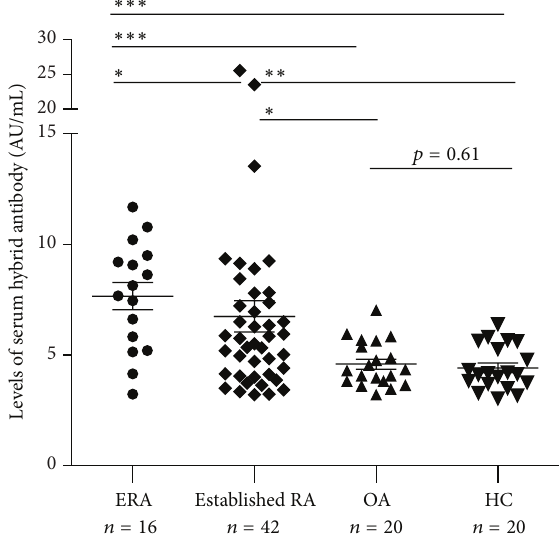
Figure 1: Comparison of levels of 𝜅 / 𝜆 hybrid antibody in the sera of patients with treatment na¨ıve ERA, established RA, OA, and HC. Serum levels of 𝜅 / 𝜆 hybrid antibody were measured by enzyme- linked immunosorbent assay in patients with ERA ( 𝑛 = 16 ), established RA ( 𝑛 = 42 ), OA ( 𝑛 = 20 ), and HC ( 𝑛 = 20 ). Serum levels of 𝜅 / 𝜆 hybrid antibody were both significantly higher in patients with ERA and established RA compared with those in OA ( 𝑝 = 0.0003 and 𝑝 = 0.0157 , resp.) and HC ( 𝑝 = 0.0002 and 𝑝 = 0.006 , resp.). Concentrations of 𝜅 / 𝜆 hybrids antibody are presented in arbitrary units (AU/mL). Symbols represent individual subjects; solid line was labeled at mean with SEM. 𝑝 values were determined using Mann-Whitney 𝑈 test, ∗ 𝑝 < 0.05 , ∗∗ 𝑝 < 0.01 , and ∗∗∗ 𝑝 < 0.001